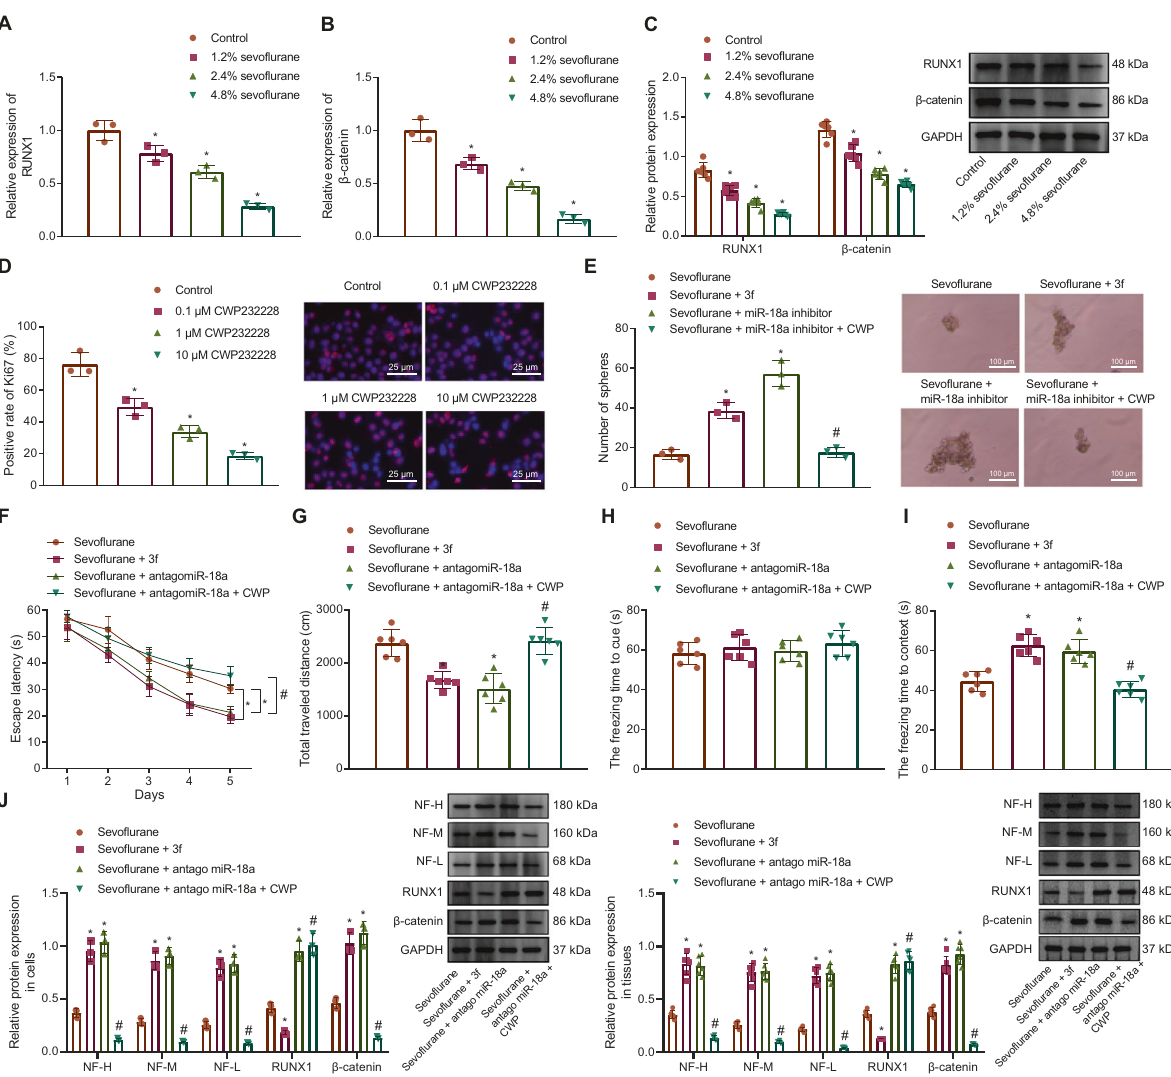
Fig. 5 Sevo fl urane regulates miR-18a-mediated RUNX1/Wnt/ β -catenin signal pathway to suppress NSC proliferation and rat neurodevelopment. A The mRNA expression of RUNX1 under different concentrations of sevo fl urane treatment detected by RT-qPCR. B The mRNA expression of β -catenin under different concentrations of sevo fl urane treatment detected by RT-qPCR. C The protein expression of RUNX1 and β -catenin under different concentrations of sevo fl urane treatment detected by Western blot analysis. D The expression of Ki67 protein in NSCs after different concentrations of CWP232228 treatment detected by IHC staining (bar = 25 μ m); PI: the nucleus in red fl uorescence, Ki67: green fl uorescence. E Intuitive and statistical plots of sphere-forming ability of NSCs after sevo fl urane, 3 f, miR-18a inhibitor, or CWP232228 treatment (bar = 100 μ m). F The effect of sevo fl urane, 3 f, miR-18a inhibitor, or CWP232228 treatment on the movement time of rats in the water maze assessed by mirris water maze test. G The effect of sevo fl urane, 3 f, miR-18a inhibitor, or CWP232228 treatment on the movement distance of rats in the open fi eld assessed by open fi eld test. H The effect of sevo fl urane, 3 f, miR-18a inhibitor, or CWP232228 treatment on the freezing time to cue of rats assessed by conditioned fear test. I The effect of sevo fl urane, 3 f, miR-18a inhibitor, or CWP232228 treatment on the freezing time to context of rats assessed by conditioned fear test. J The expression of neural cell marker protein (NF-H/NF-M/NF-L) in cells and tissues detected by Western blot analysis. * p < 0.05 vs. the control/sevo fl urane group; # p < 0.05 vs. the sevo fl urane + miR-18a inhibitor/sevo fl urane + antagomiR-18a group. n = 6. The cell experiment was repeated 3 times vital regulators for the transition between proliferation and NSCs by inhibiting the expression of dishevelled binding antagonist of differentiation, and regulate the stem cell proliferation and beta-catenin 1 and activating the Wnt/ β -catenin pathway [22]. Also, differentiation in multiple cell types including NSCs [10]. RUNX1, a miR-374b is reported as a promising target for adjusting NSC- member of the RUNX family, controls the growth and differentia- modulated neurogenesis by targeting hairy and enhancer of split 1 tion of certain NSCs and has the ability to promote NSC [23]. Likewise, Li et al. have pointed out that miR-18a regulates neural differentiation to repair the injured complex nervous system [11]. precursor cells and ful fi lls a pivotal role in the cell proliferation [8], and Additionally, the transcription factor RUNX1 was reported to be a miR-18a is indicated to decrease the percentage of the proliferative target gene of miR-18a-5p [25], and RUNX1was directly targeted by factor Ki67-postive cells [24], which is partially consistent with miR-18a in gastric cancer cells [26]. Given the above evidence, the our study. inhibitory role of miR-18a in RUNX1 expression and the miR-18a/ Next, our report found that miR-18a targeted RUNX1 to limit the RUNX1 axis functioning in NSC proliferation can be veri fi ed. proliferation of NSCs. It has been reported that RUNX genes serve as